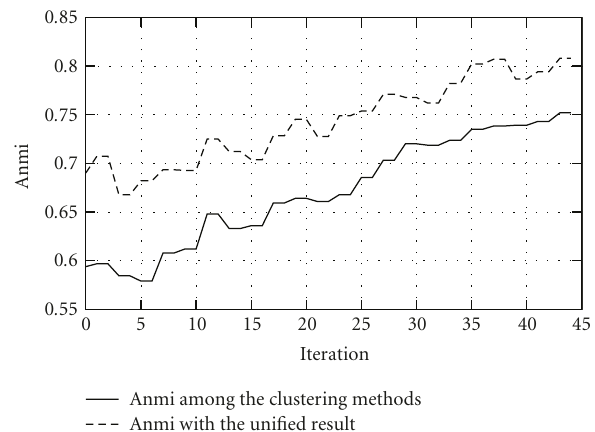
Figure 12: Evolution of the anmi index among the clustering methods and the average nmi between the results and the unified